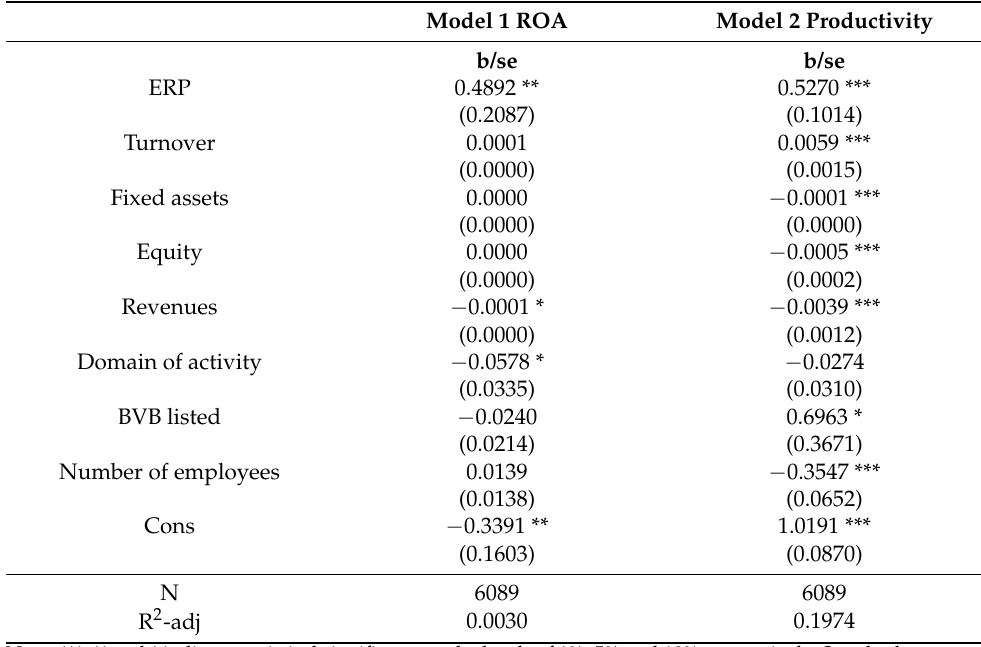
Table 7. Results regarding the influence of ERP on performance (ROA and